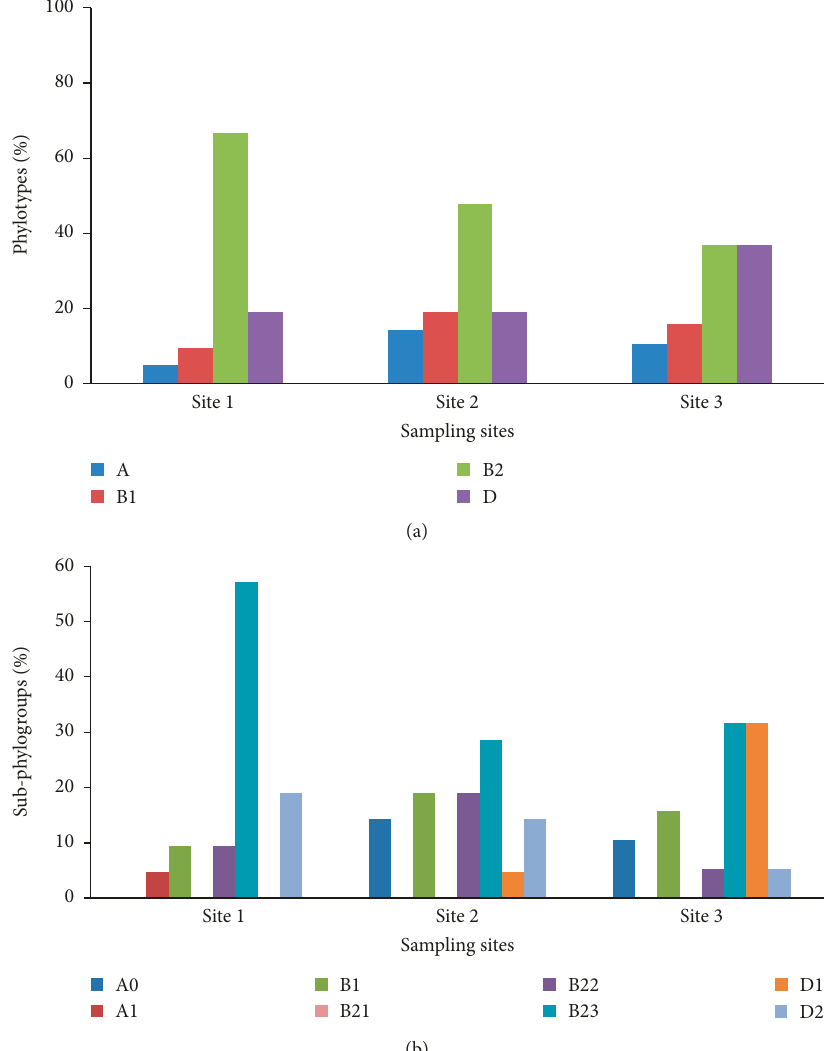
Figure 2: Distribution of the E. coli phylogenetic groups among the three sampling sites located along the Al-Hillah River. Distribution of E. coli (a) according to the phylogenetic groups (A, B1, B2, D) and (b) according to phylogenetic groups subtyping (A 0 /A 1 , B2 2 /B2 3 , and D 1 /D 2 ).